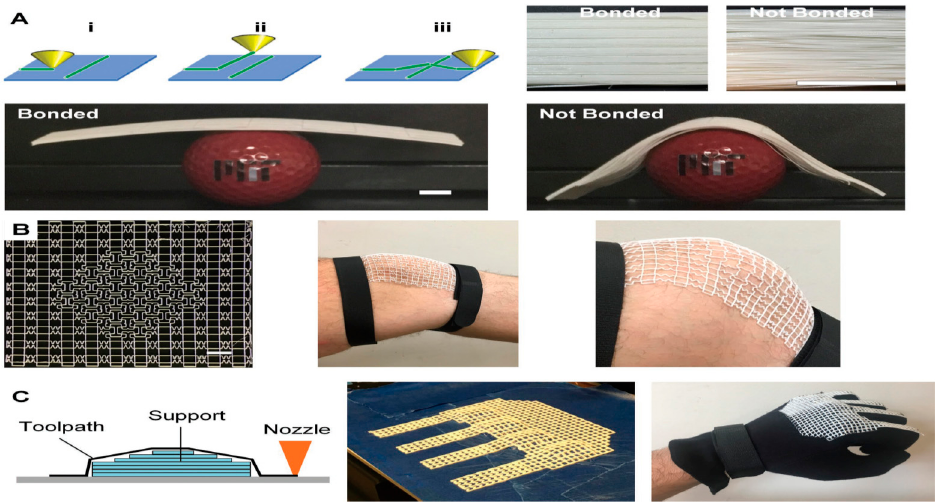
Figure 19. Additional capabilities of mesh printing: ( a ) modulation of fiber–fiber bonding, ( b ) a mesh (scale bar 10 mm) with locally patterned negative Poisson’s ratio unit cells, which featuring anisotropic mechanics and showing its ability to conform to a knee. ( c ) Printing of conformal meshes onto a template [106] .